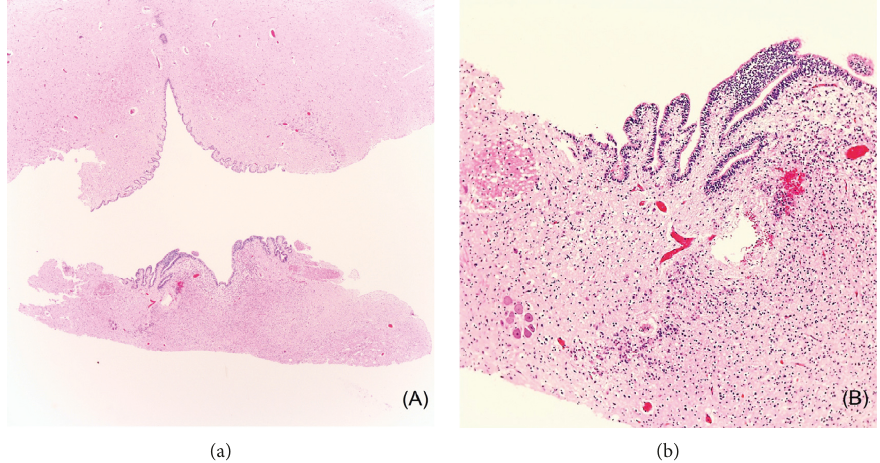
Figure 3: (a) Flattened linear fourth ventricle with scant, abortive foliae and no delineation of cerebellar nuclei. (b) Scant, abortive foliae with molecular, Purkinje, and granular layers.